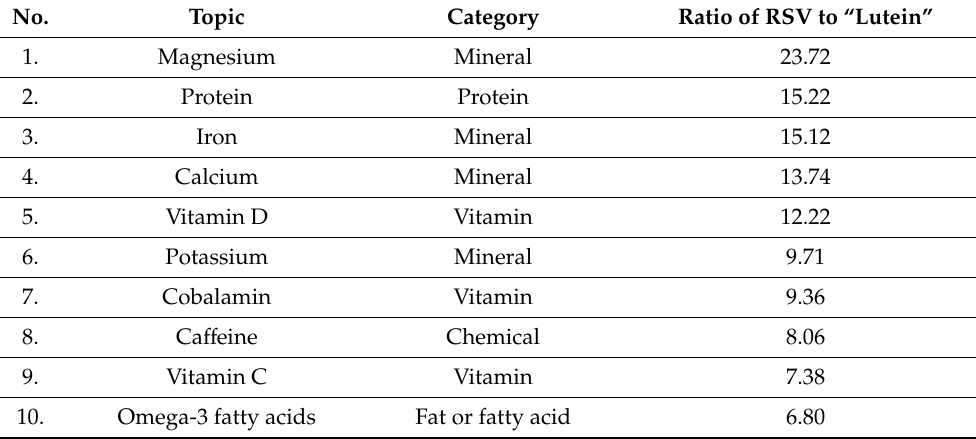
Table 2. Popularity of the 20 most popular topics associated with dietary supplements, as a ratio with the value for “lutein” (adjusted data; relative search volume (RSV) over